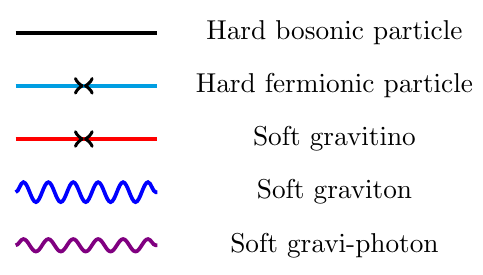
Figure 1 . Conventions for Feynman diagrams.